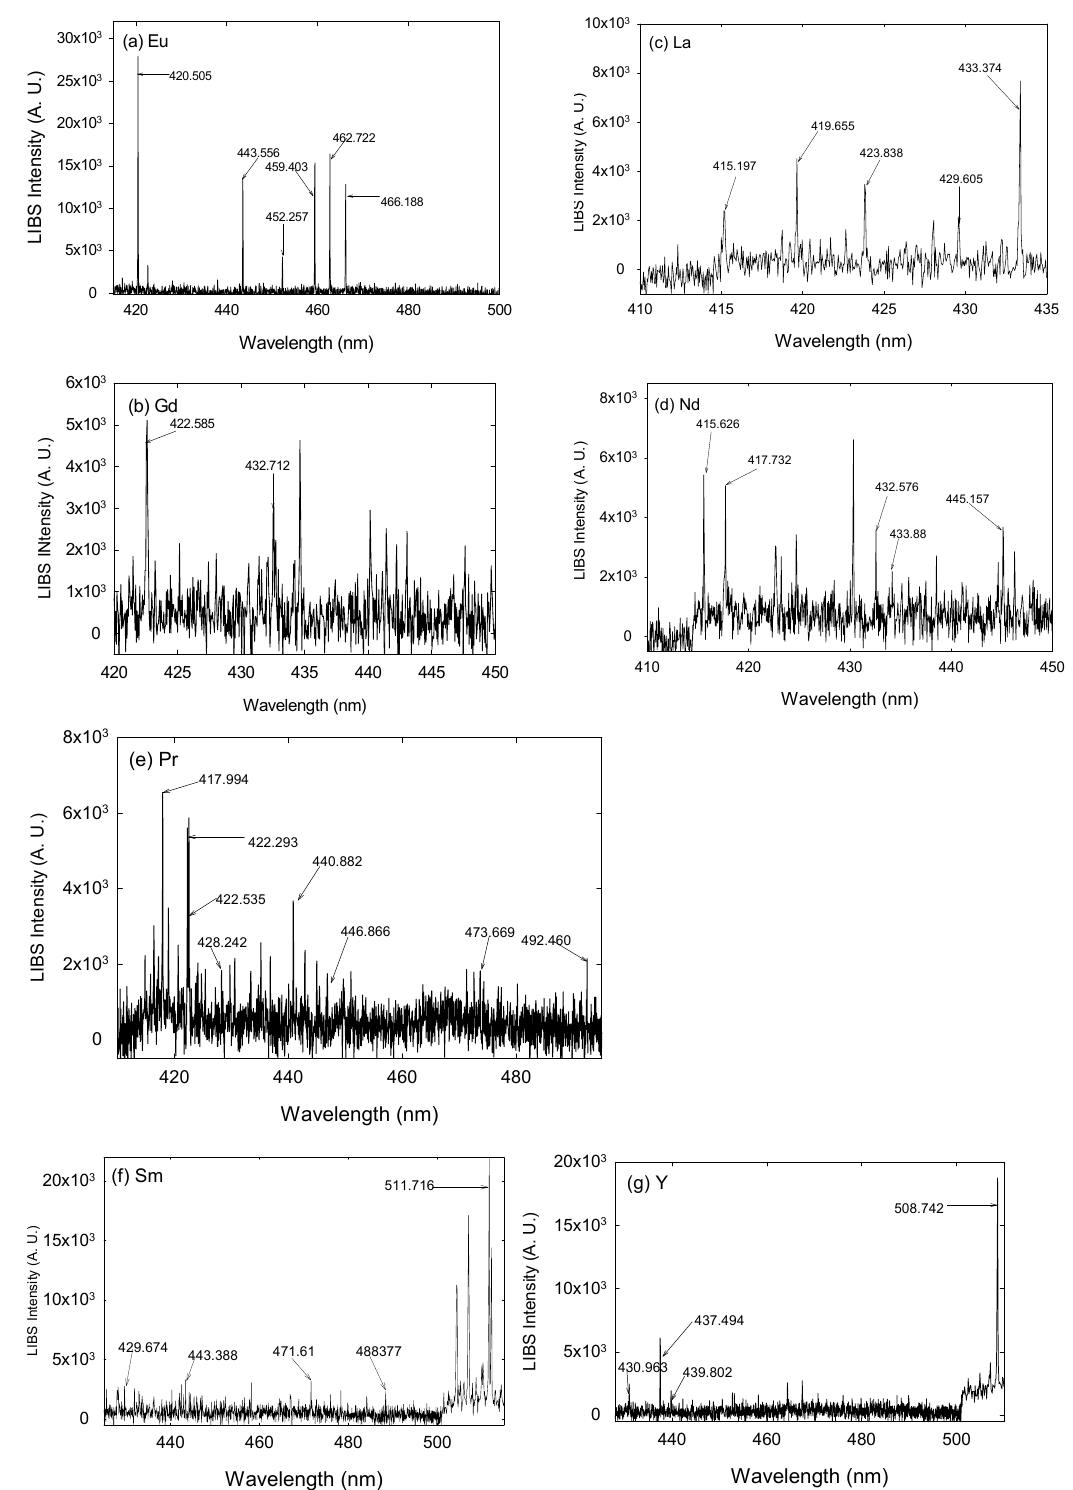
Figure 4. The LIBS spectra for 5% of ( a ) europium, ( b ) gadolinium, ( c ) lanthanum, and ( d ) neodymium ( e ) praseodymium, ( f ) samarium, and ( g ) yttrium in 95% graphite powder in a narrow wavelength range showing the individual peaks that are characteristics of the elements shown here.